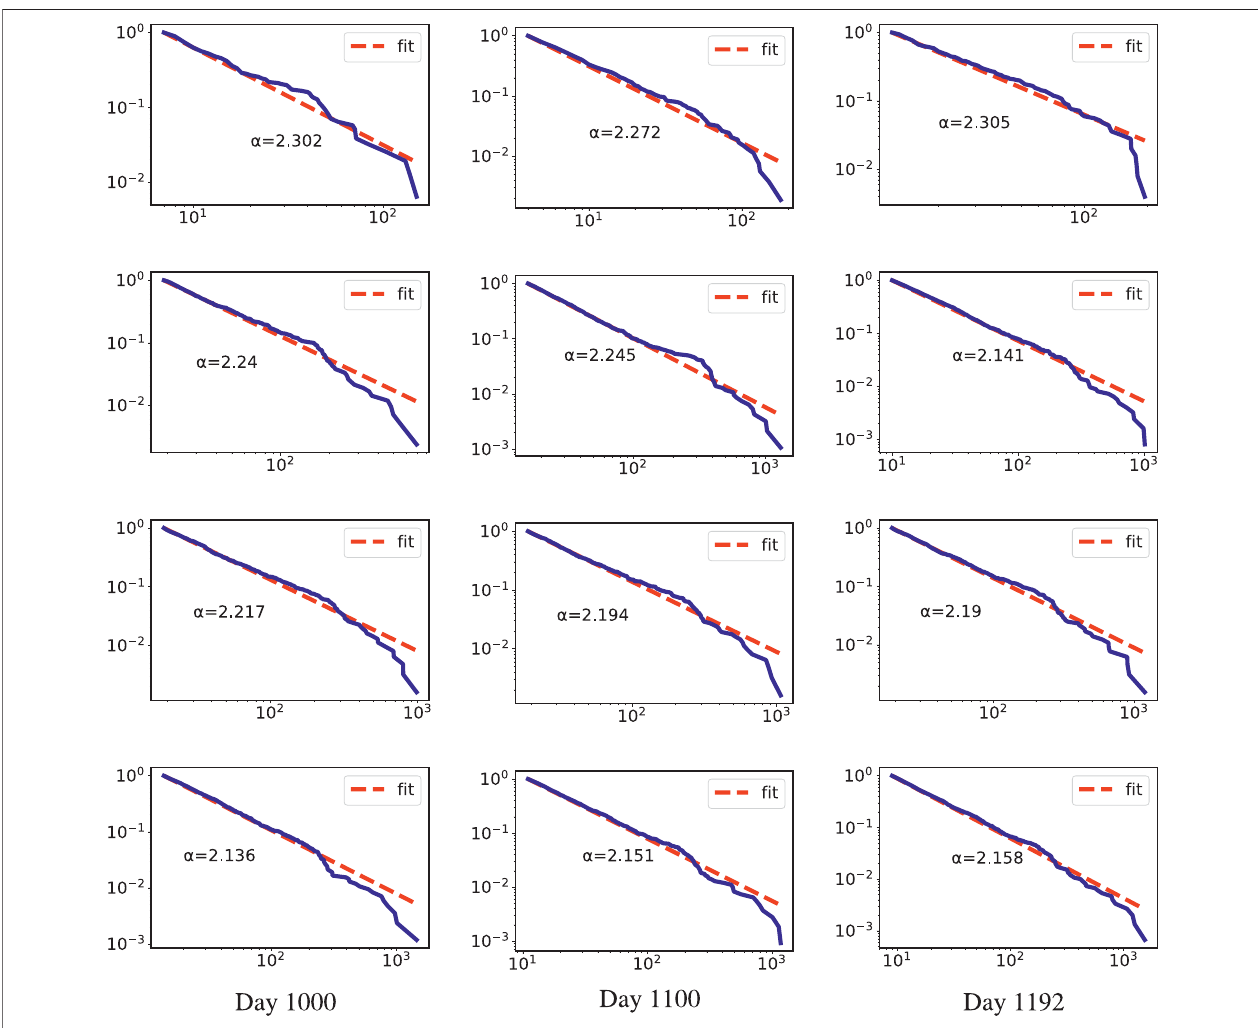
FIGURE 4 | Complementary cumulative distribution of degrees per 100 days of the network and parameters fi tted using powerlaw .